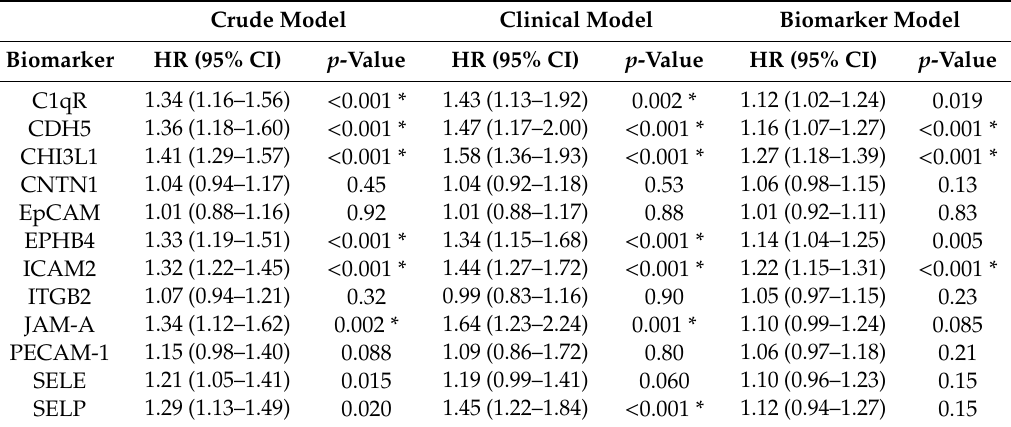
Table 3. Associations between the slope of biomarkers of cell adhesion and the primary